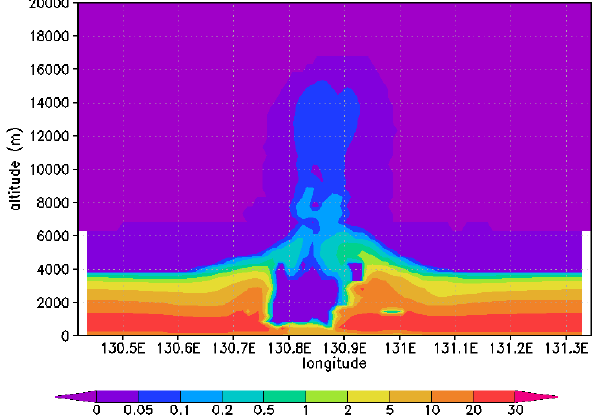
Fig. 7. Longitude-altitude cross-section at 12.4 ◦ S at t 0 + 30min of the BrWMR for (a) CHBr 2 OOH and (b) CBr 2 O from the PERT1 Figure 7: Longitude-altitude cross-section at 12.4° S at t simulation. CHBr OOH and b) CBr O from the PERT1 simulation. 2 2